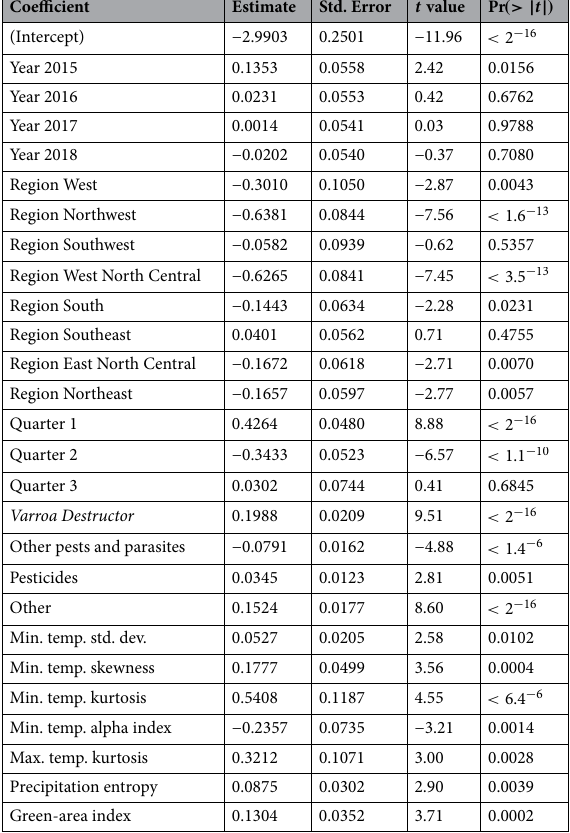
Table 1. Features selected using the mixed-integer programming procedure described in Insolia et al. (2021) 50 for the years 2015-2019, with corresponding coefficient estimates, standard errors, t -statistics and p -values computed on a subset encompassing 90% of the observations (these are 607 selected as “non-outlying”, concurrently with the feature selection). Group-constraints are used to ensure that the terms introduced to represent each categorical control, e.g., the three terms representing quarters (the first one being January- March), are either all selected or all excluded (the categorical controls used are year, quarter and climatic 2 = 0.601 region). The model has an R